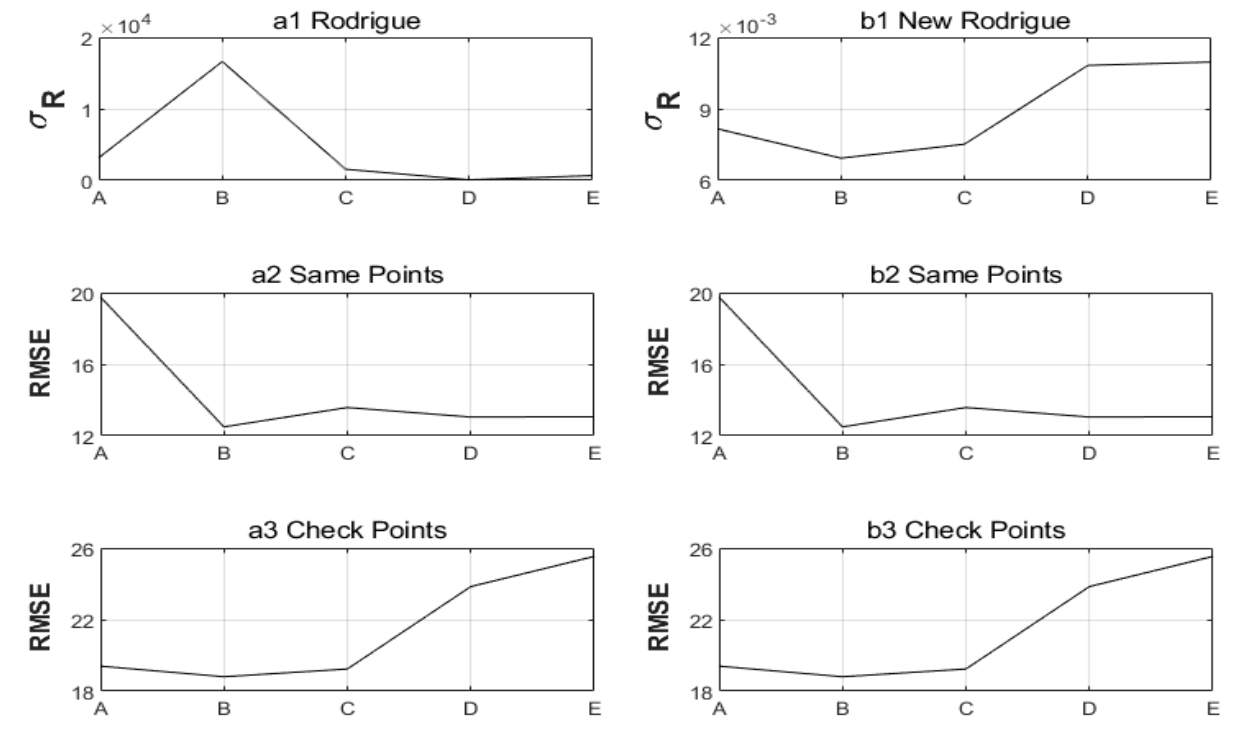
Figure 6. Transformation precision comparison of the R-Method and NR-Method for practical engineering application (each x axis value represents a different case selects of the common points, each y axis value represents a different precision for a different precision index ( σ R (a.u.), RMSE (mm)) (( a1 – a3 ) shows the results of the R-Method, ( b1 – b3 ) shows the results of the NR-Method).